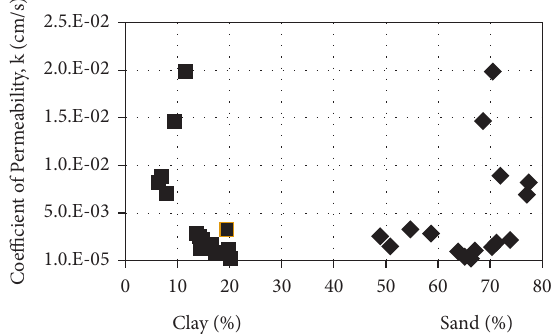
Figure 7: Relationship between the coefficient of permeability and water